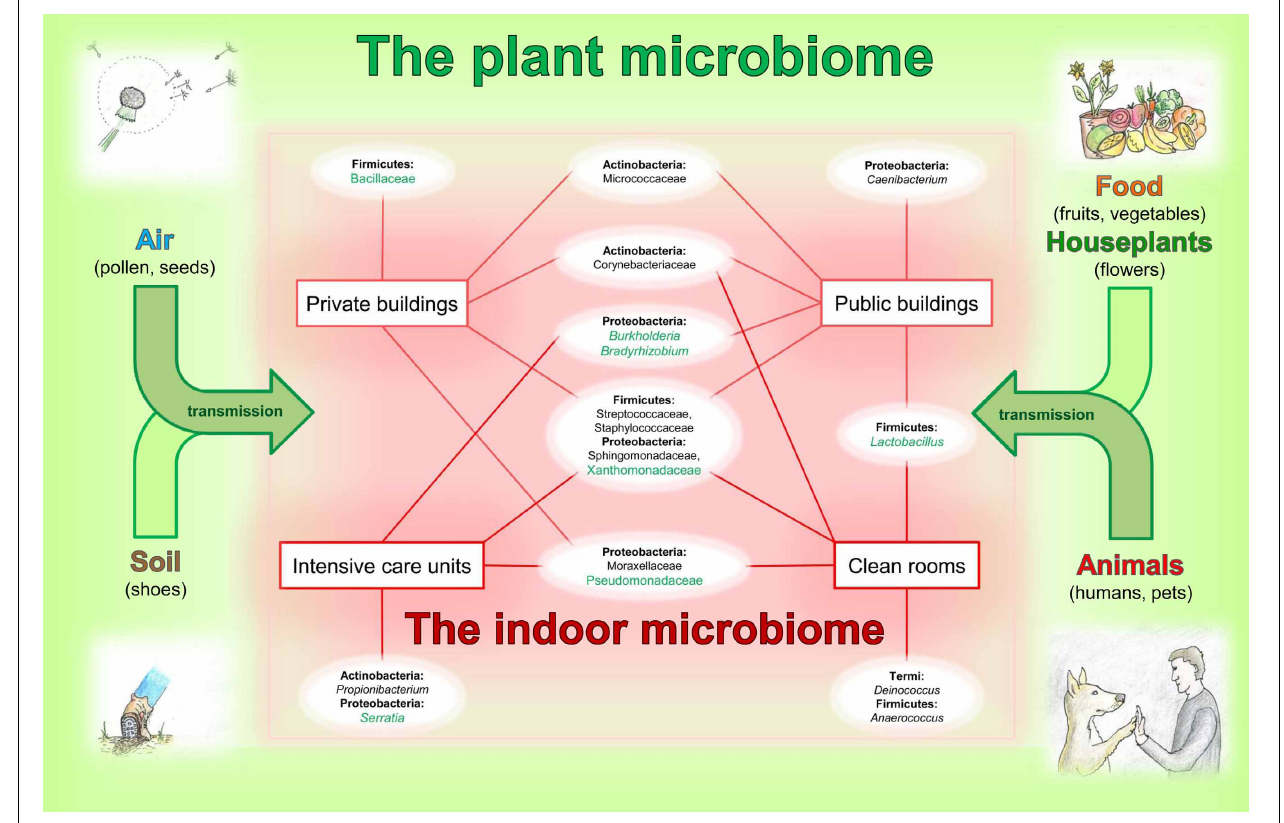
FIGURE 1 | Relationships between the plant and indoor microbiome. The indoor microbiomes, influenced by transmissions via air, soil, food, houseplants and animals from plant microbiomes, presents an overview on typical and dominant bacterial groups occurring in the built environment. Schematic chart represents occurrence of the bacterial inhabitants indoors.